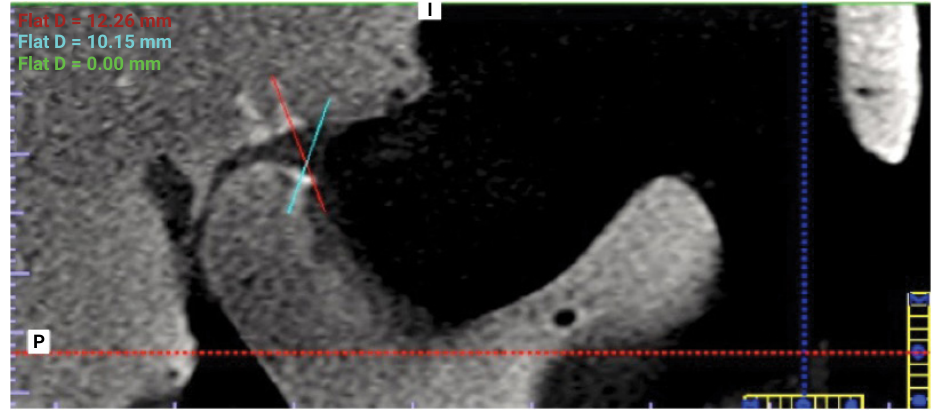
Figure 5. Measuring changes between the anterior-posterior distances of the metallic markers (screws) on the sagittal reformatting. Lines (blue and red) representing the long axis of the screws and were done using the DISTANCE tool of the software. At the top of the screw head of the condyle, the distance between the lines (blue and red) were measured perpendicularly (green result that is showed at the picture upper left corner = 0.0mm).